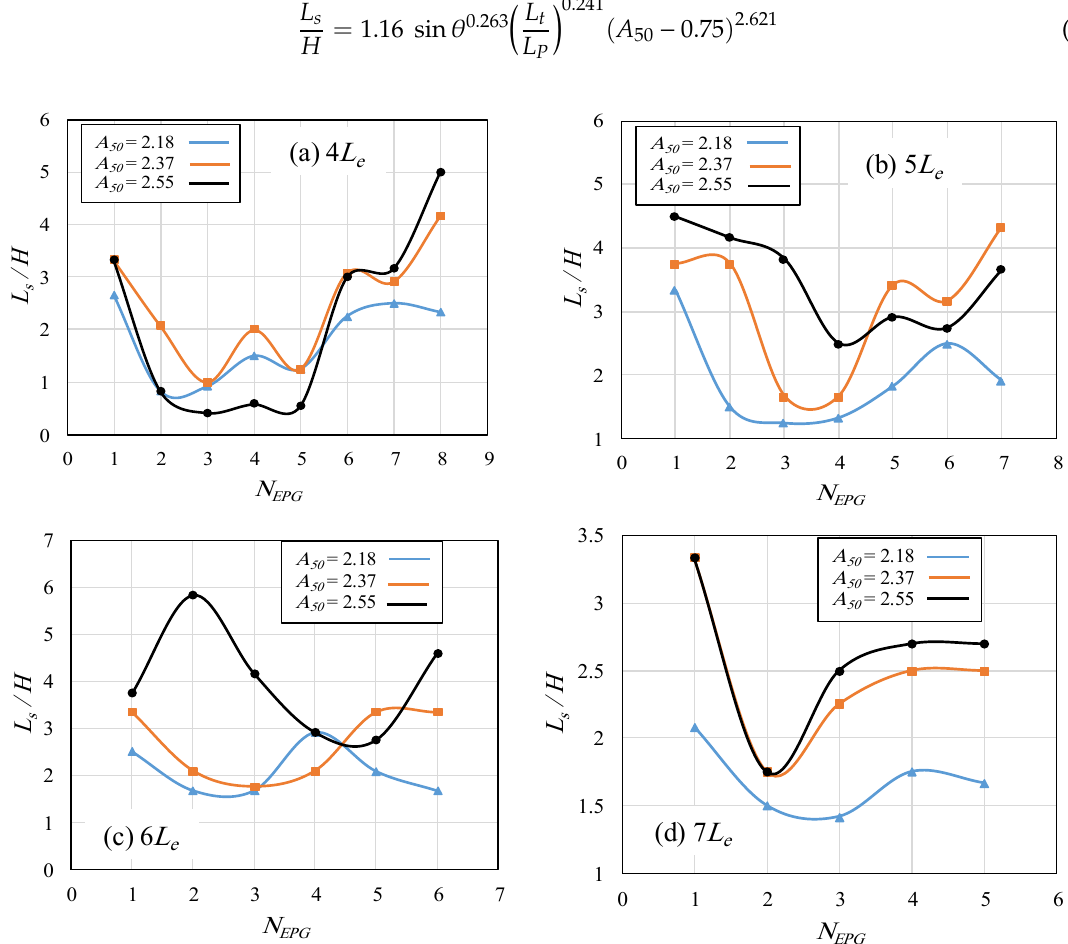
Figure 10. Relationship between the maximum scour length occurred around the first EPG and the maximum scour length in the other EPGs at different distances and hydraulic conditions. ( a ) 4 L e , ( b ) 5 L e , ( c ) 6 L e , and ( d ) 7 L e .